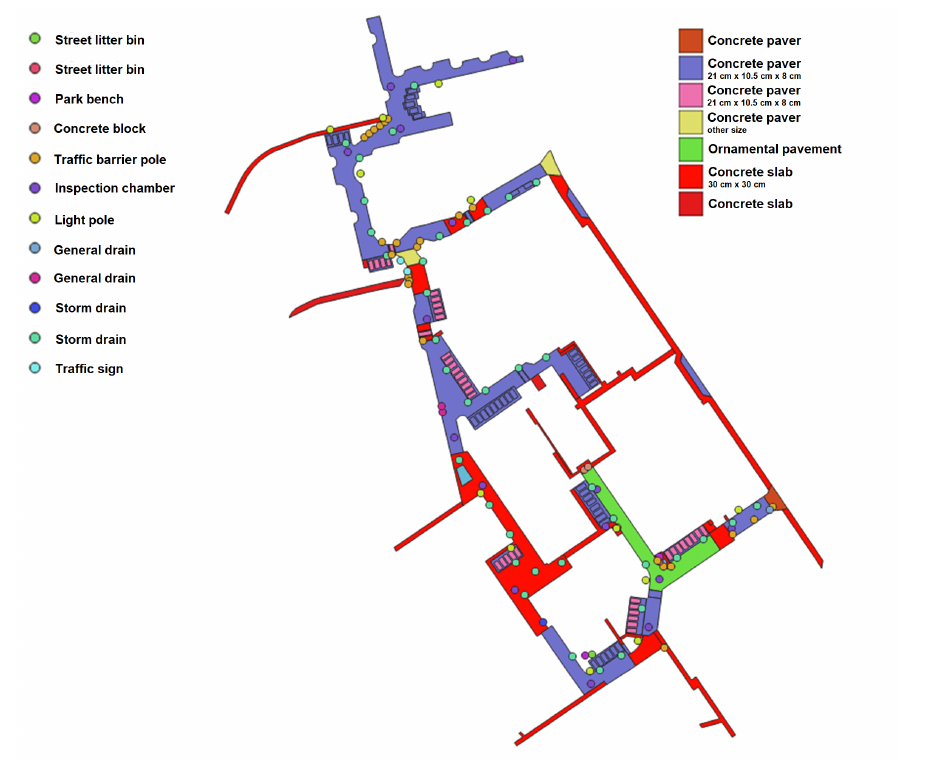
Figure 4. Results of scanning Griffiersveld through collecting images, radar and laser